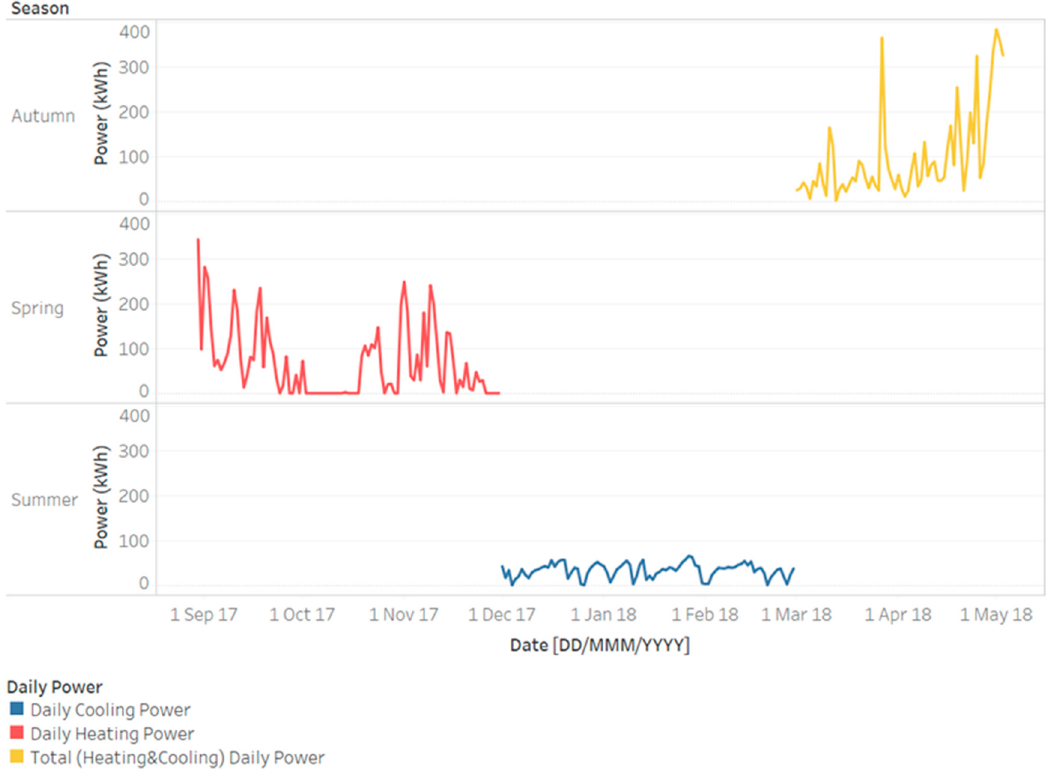
Figure 5. Weather seasons mapped with daily heating in spring, cooling in summer and total energy consumption in autumn in the greenhouse. Table 4. Total energy consumption in each of the four seasons during the full capsicum crop